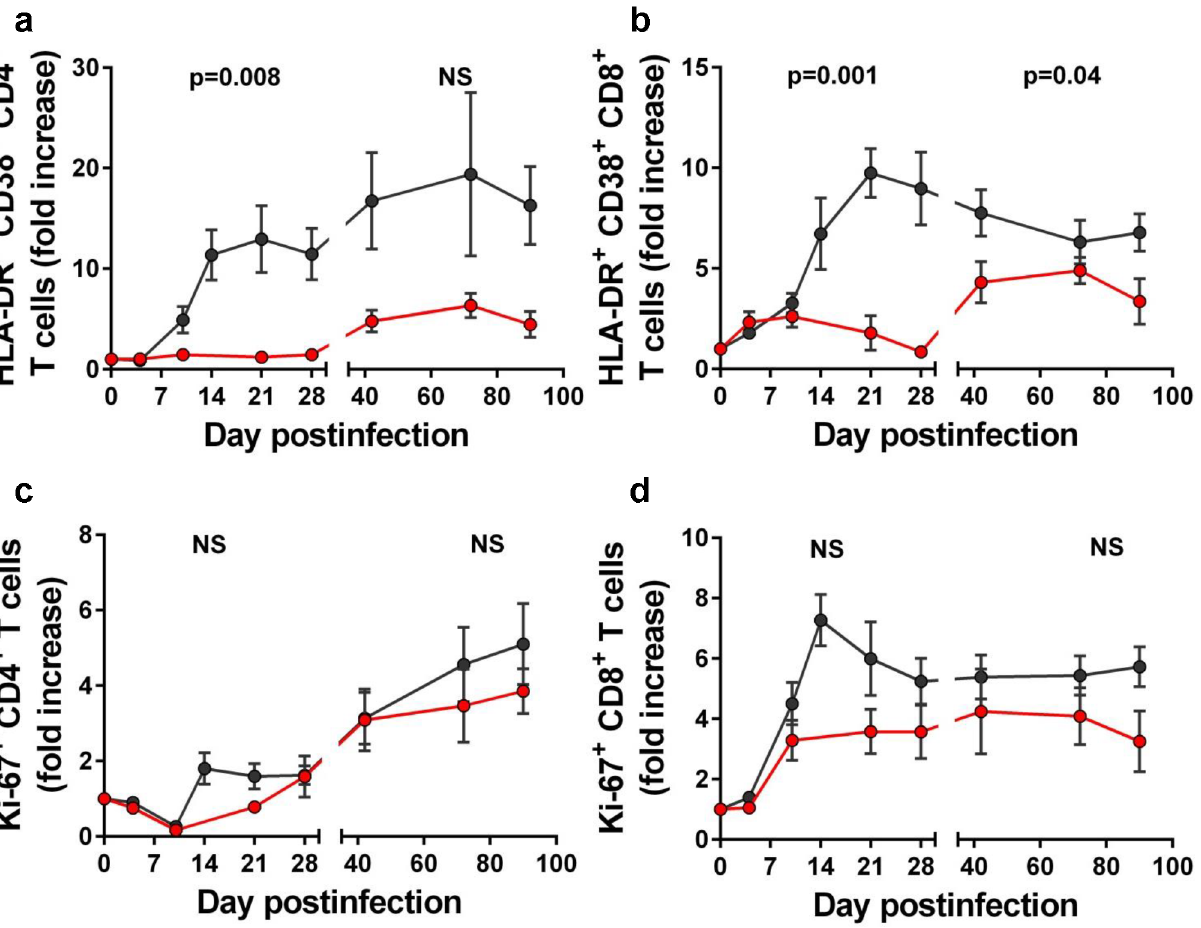
Fig 3. Rifaximin (RFX) + sulfasalazine (SFZ) therapy impacts T cell immune activation during acute and early chronic SIVsab infection of pigtailed macaques (PTMs). Significant differences were observed between SIVsab-infected PTMs receiving RFX+SFZ (red) and untreated controls (black) with regard to CD38 and HLA-DR expression by CD4 + T cells (a) and CD8 + T cells (b). Conversely, Ki-67 expression by CD4 + T cells (c) and CD8 + T cells (d) was not statistically different between the two groups. Shown are the average values for each group and standard error of means.